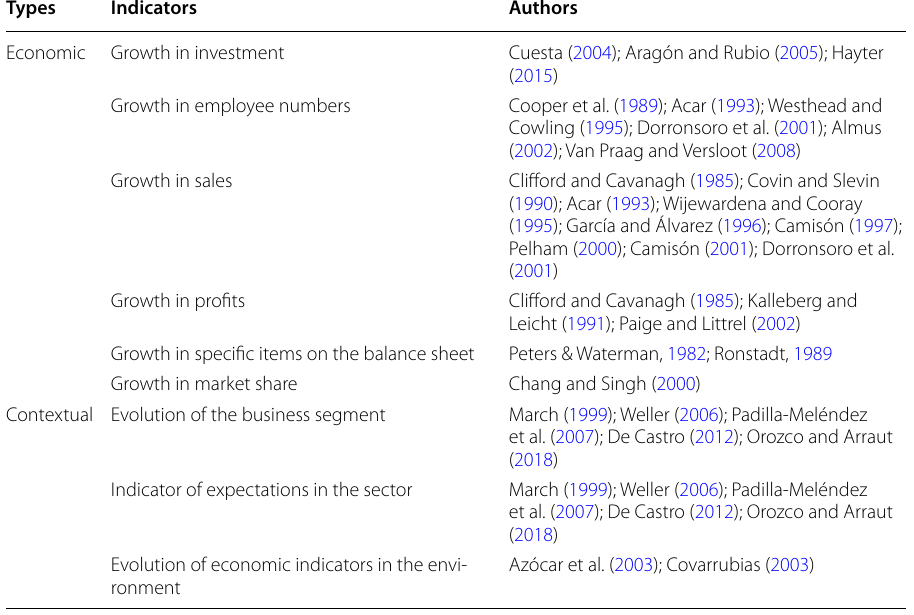
Table 3 Some indicators to measure